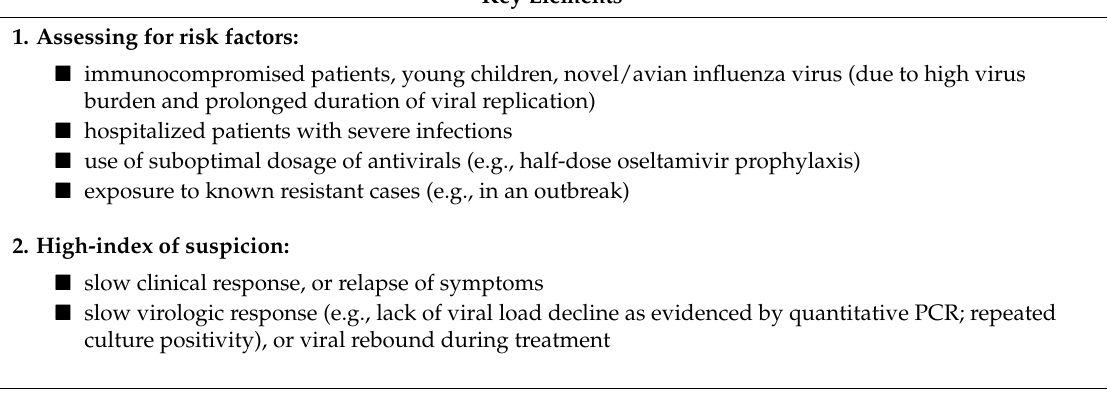
Detecting influenza antiviral resistance in the clinical setting and proposed management